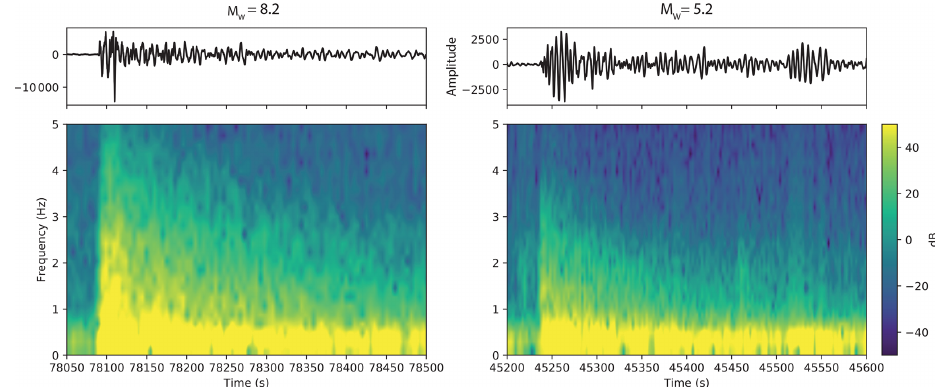
Figure 3. Power-spectral density plots of two earthquakes recorded by the CIMDEF array. They cover both ends of the used magnitudes, thus proving the existence of energy at the selected frequency